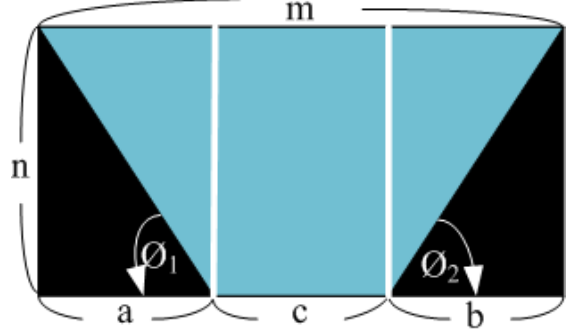
Figure 5. Example of TVTM transformed